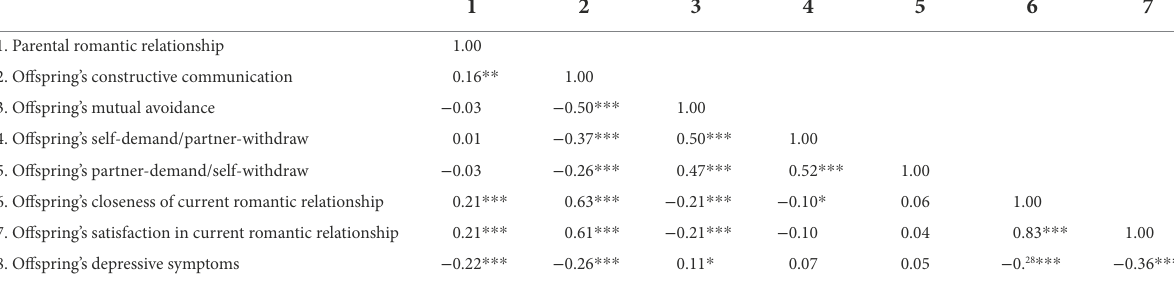
TABLE 3 Correlations among variables.